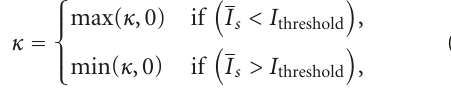
where I threshold is calculated as the average of pixel intensities along the direction perpendicular to the gradient at the extrema of the local neighborhood within the filter window